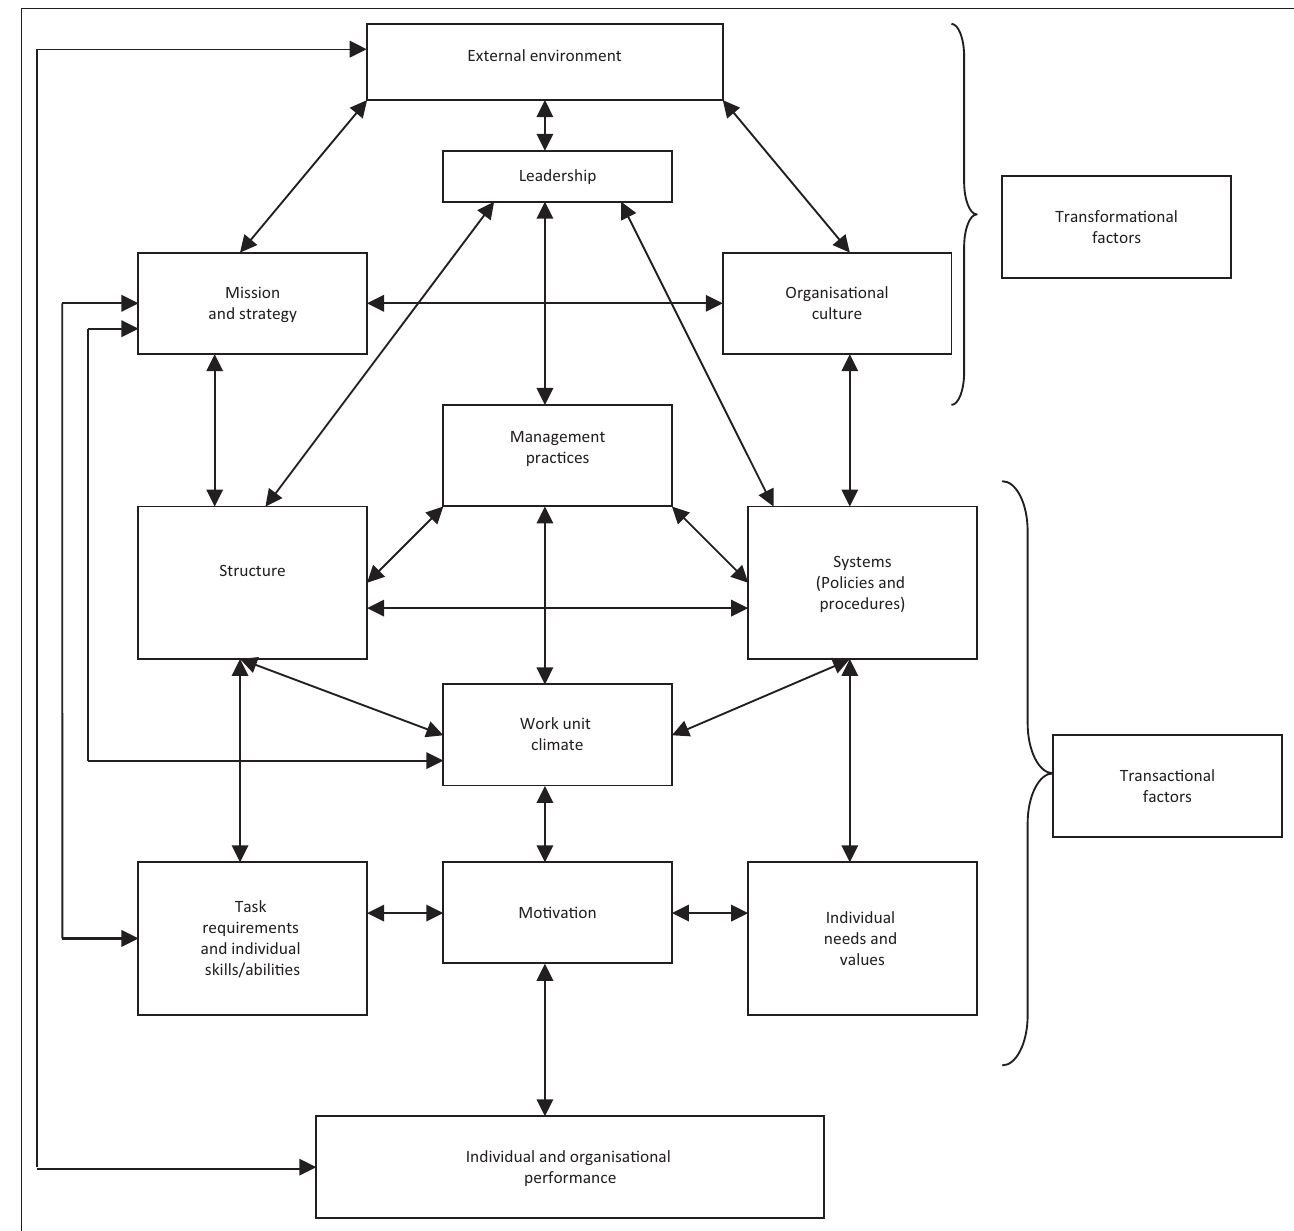
FIGURE 2: The causal model of organisational